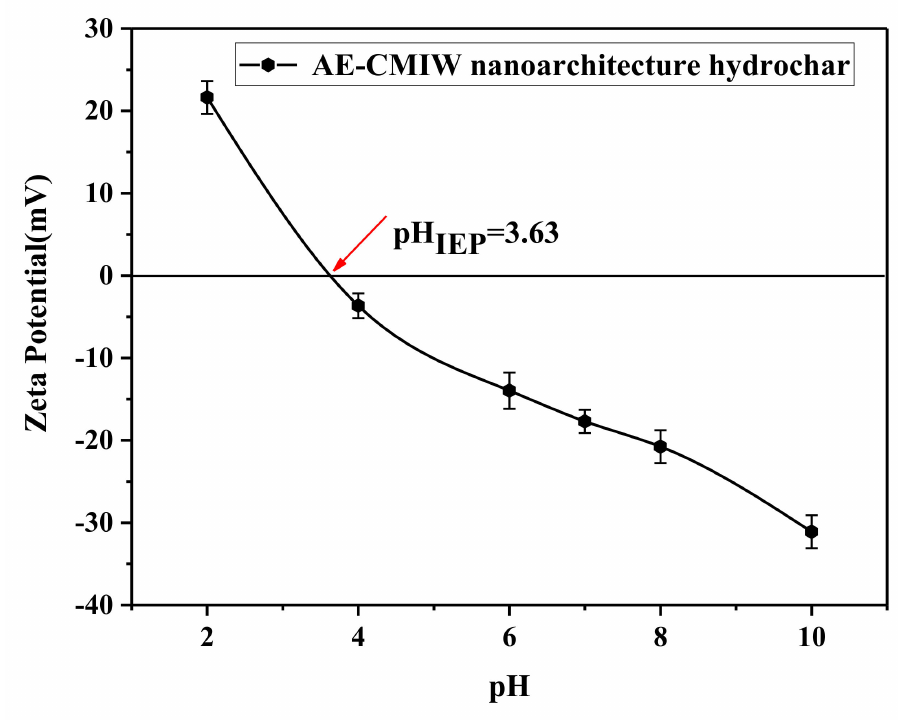
Figure 5. Plot for the pH IEP determination of AE-CMIW